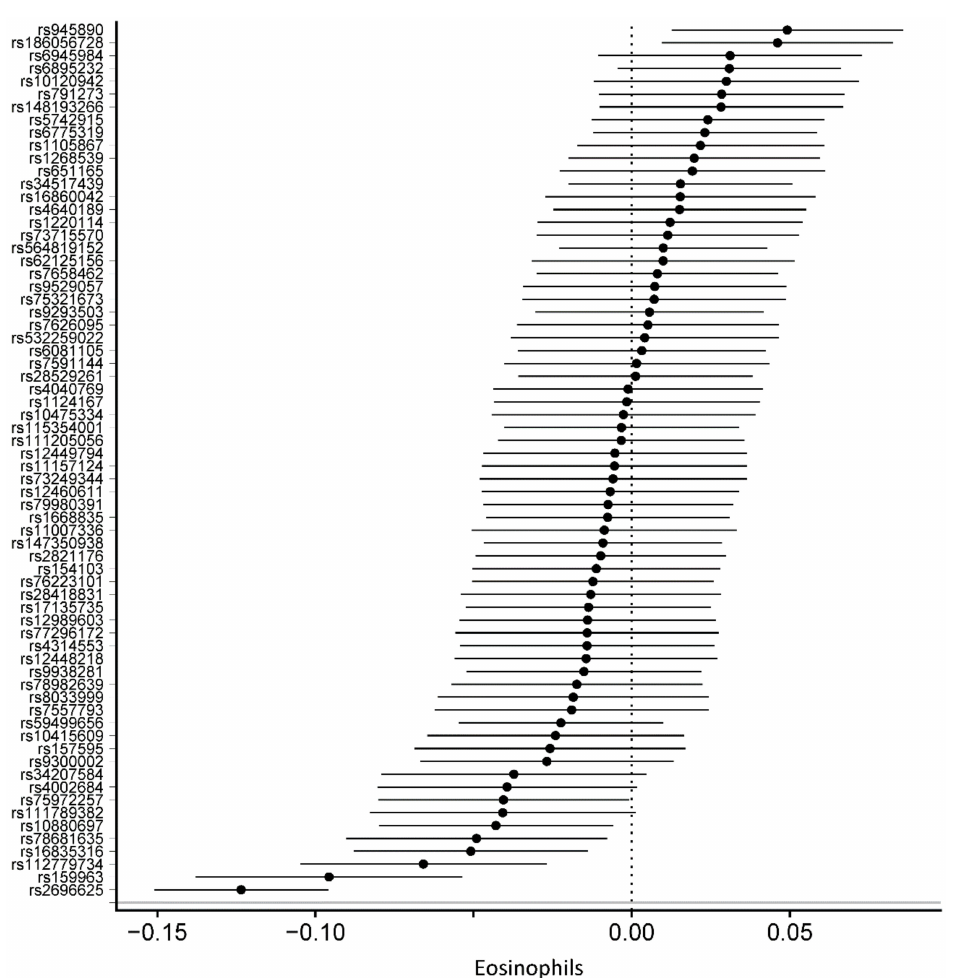
Figure 4. Forest plot of physical activity single nucleotide polymorphisms on eosinophil